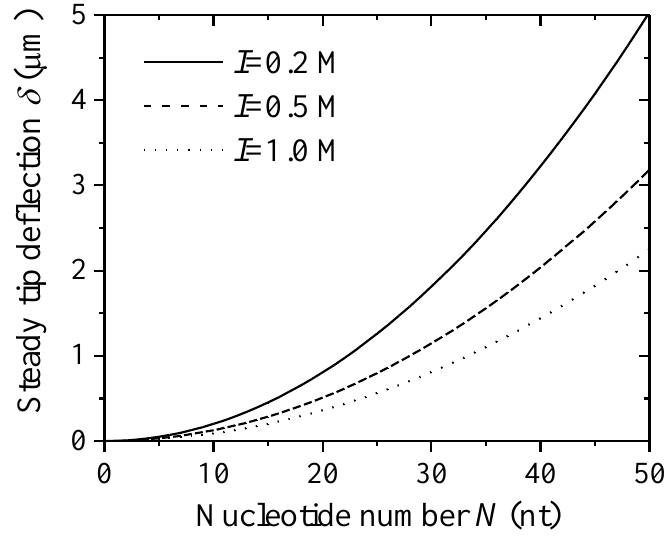
Figure 4. Steady tip deflection of a DNA-microcantilever sensor as a function of nucleotide number under different salt concentrations.